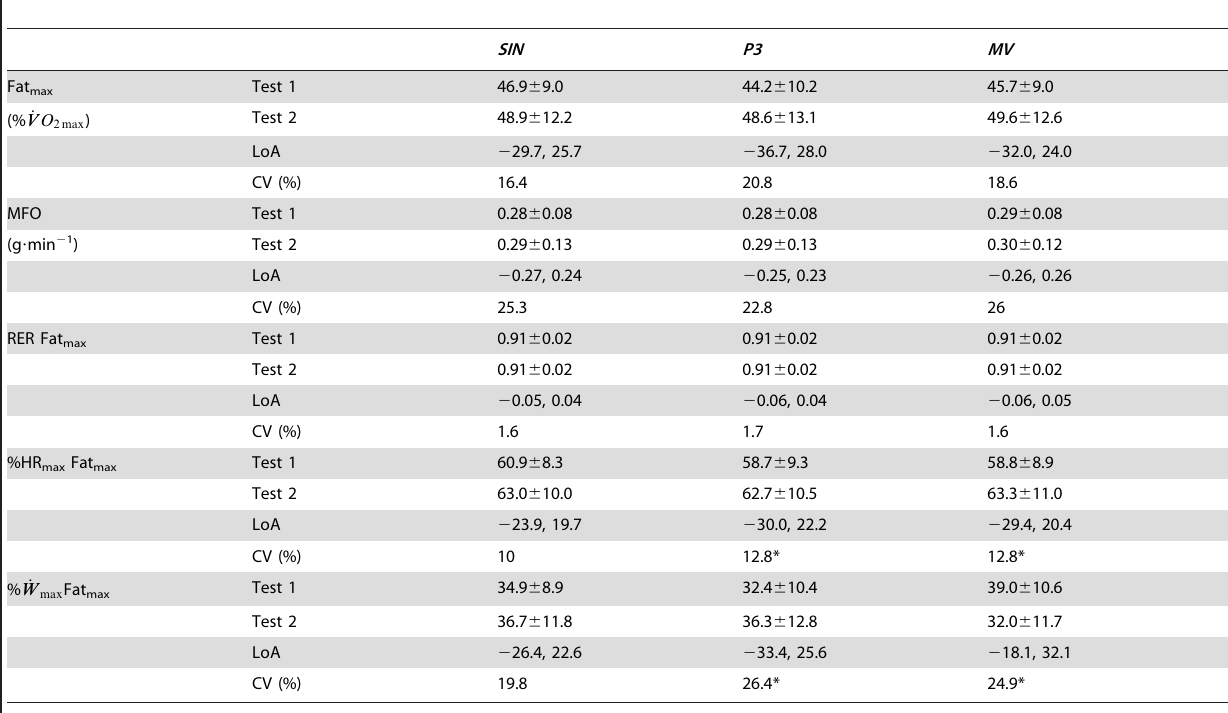
Table 2. Average values, limits of agreement and CVs for Fat max and physiological measures at Fat max determined with three approaches: SIN, P3 and